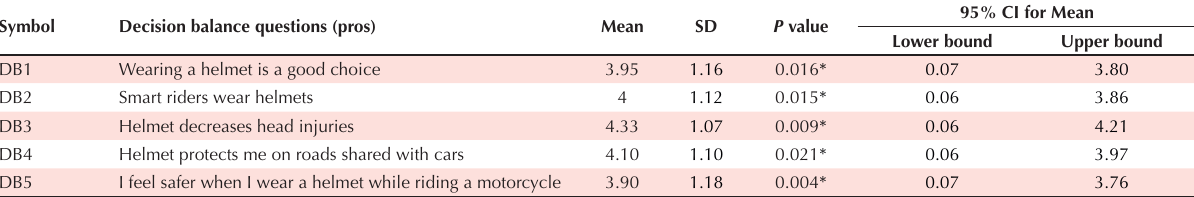
Table 1. One-way ANOVA to compare "pros" scores across stages of change Symbol